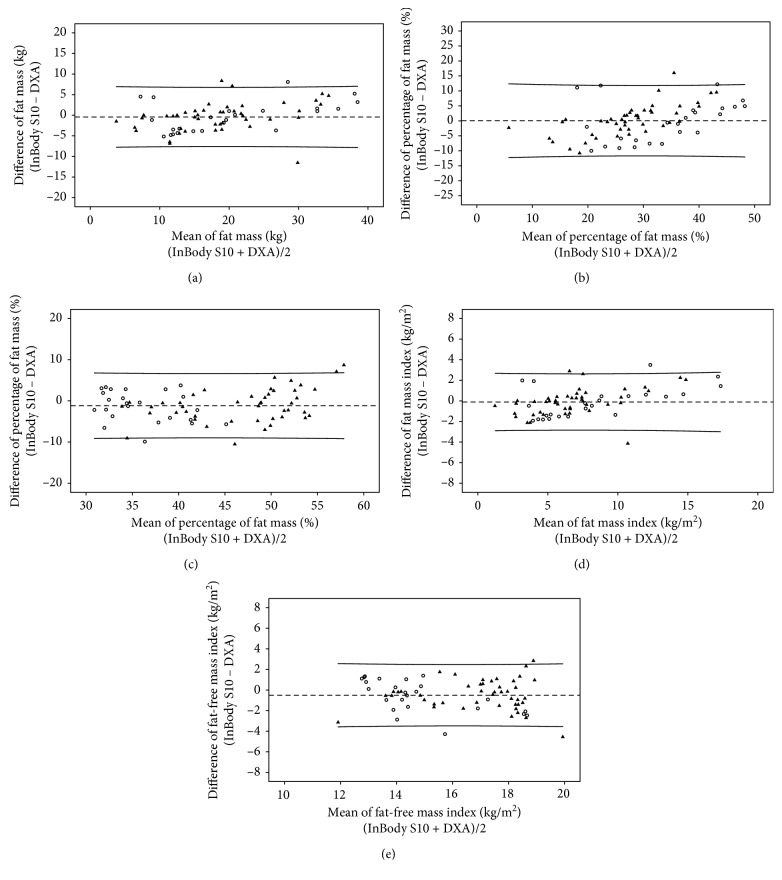
The agreement between DXA and BIA S10 in (a) fat mass, (b) percentage of fat mass, (c) fat-free mass, (d) fat mass index, and (e) fat-free mass index. Black filled-in triangles represent values of male, and black circles represent values of female.